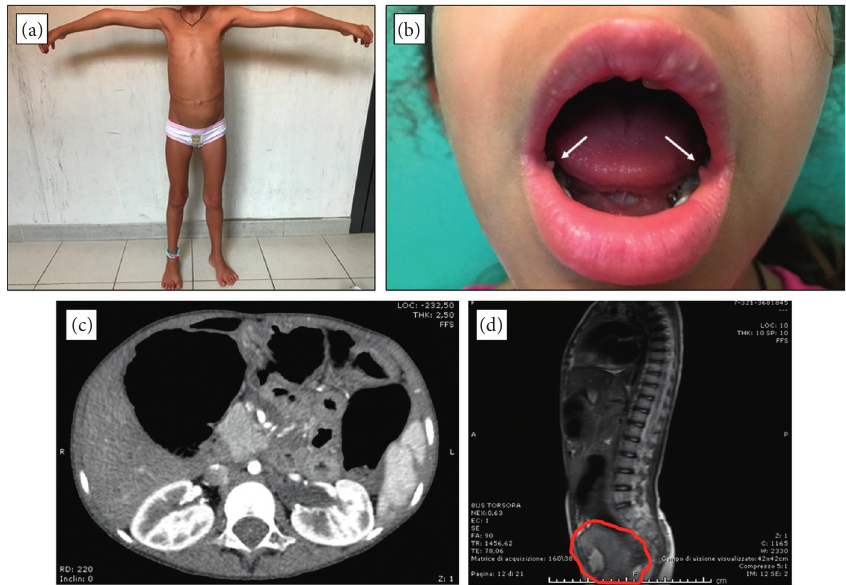
Figure 1: Nonendocrine features present in our patient. (a) Marfanoid habitus with long arms and long legs with respect to the trunk and skeletal abnormalities. (b) Bilateral mucosal neuromas of the mouth as indicated by the 2 arrows. (c) CT cross section of the abdomen showing the megacolon. (d) MRI sagittal section of the pelvic plexiform